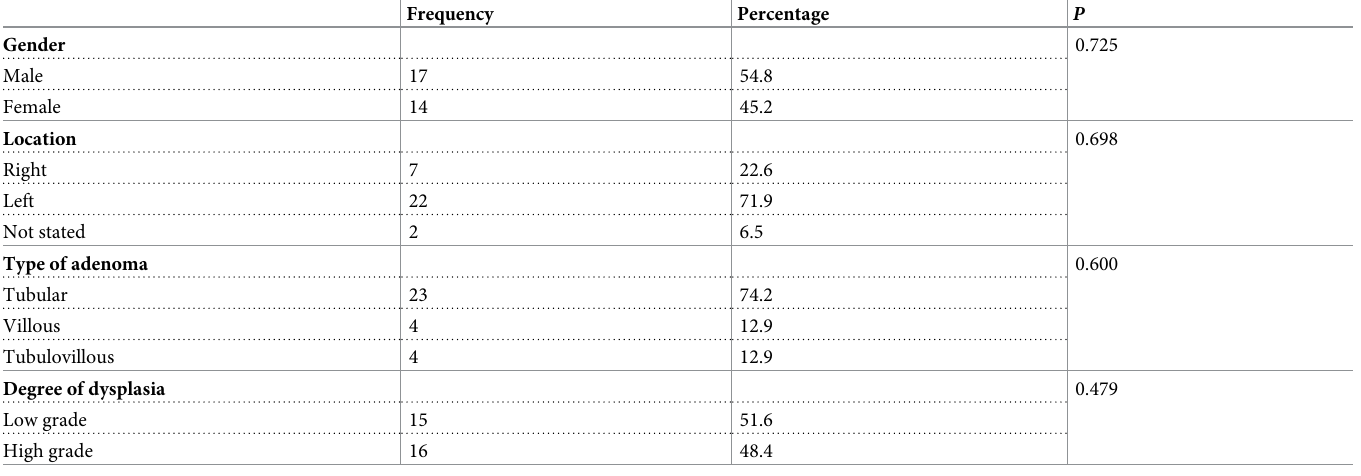
Table 2. Colorectal adenomatous polyp features and COX-2 expression by